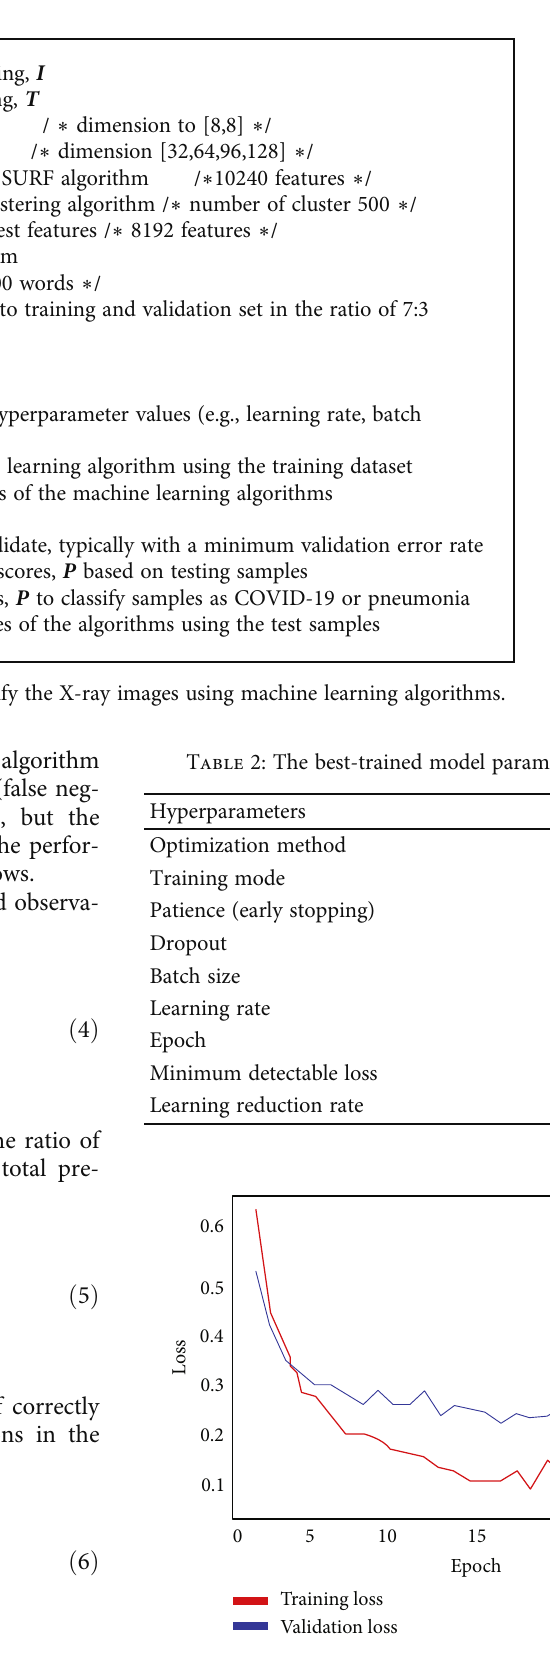
Figure 7: The training and validation losses for